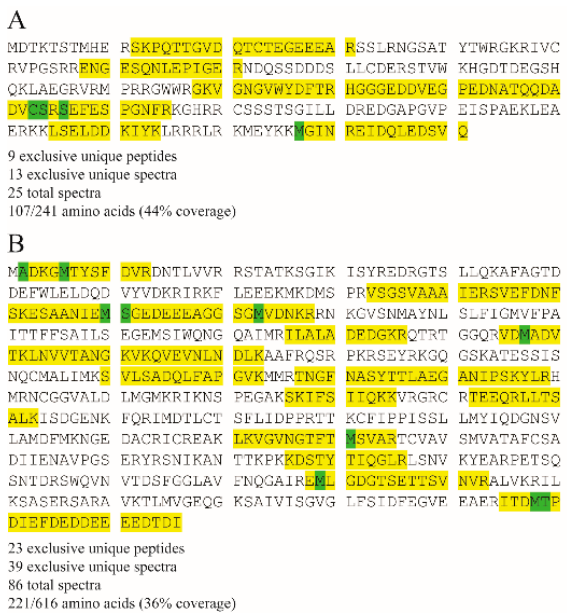
Figure 7. Identified peptides are highlighted in yellow, modifications are highlighted in green (cysteine propionamidation (+71 Da), methionine oxidation (+16 Da), N-terminal acetylation (+42 Da), and phosphorylation (+80 Da)). Modification of cysteines with propionamide and oxidation of methionine are well-known artificial modifications. ( A ) Phosphorylation of serine-154 in the s8ORF2 protein within the peptide HGGGEDDVEGPEDNATQQDADV CS R S EFESPGNFR was identified, whereas phosphorylation of serine-156 could not unequivocally be verified by manual inspection of the corresponding MS/MS spectrum; ( B ) The NP protein was modified at alanine-2 (green) by removing the N-terminal methionine and acetylation of the following amino acid ( A DKG M TYSFDVR). Phosphorylation of serine-111 could be confirmed by identification of ESAANIE MS GEDEEEAGGSG M VDNK and SVEFDNFSKESAANIE MS GEDEEEAGGSG M VDNK. Phosphorylation of threonine-599 was found within the peptide ITD MT PDIEFDEDDEEEEDTDI.